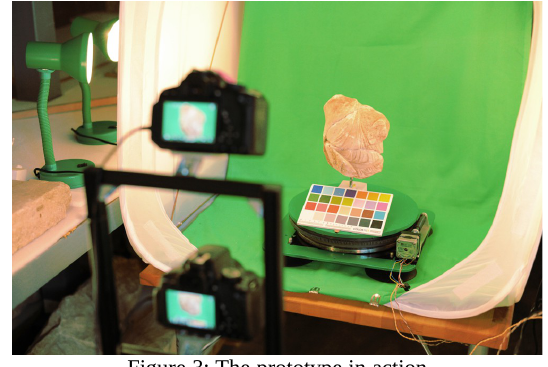
Figure 3: The prototype in action